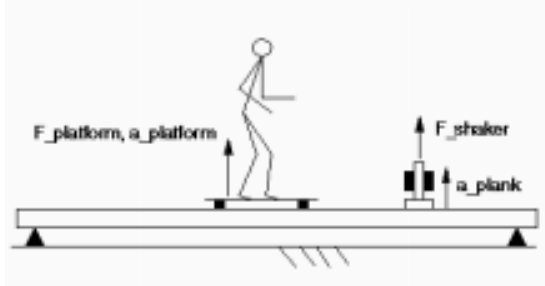
Fig. 2. Measured signals for subject standing on plank.